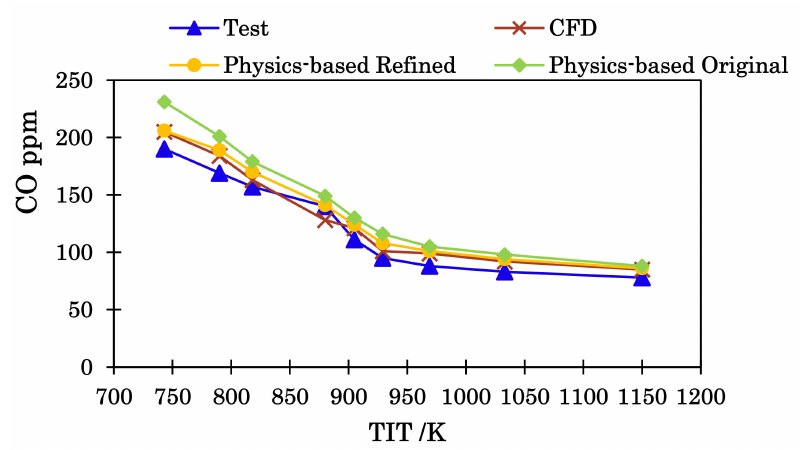
Figure 17. CO results comparisons at different